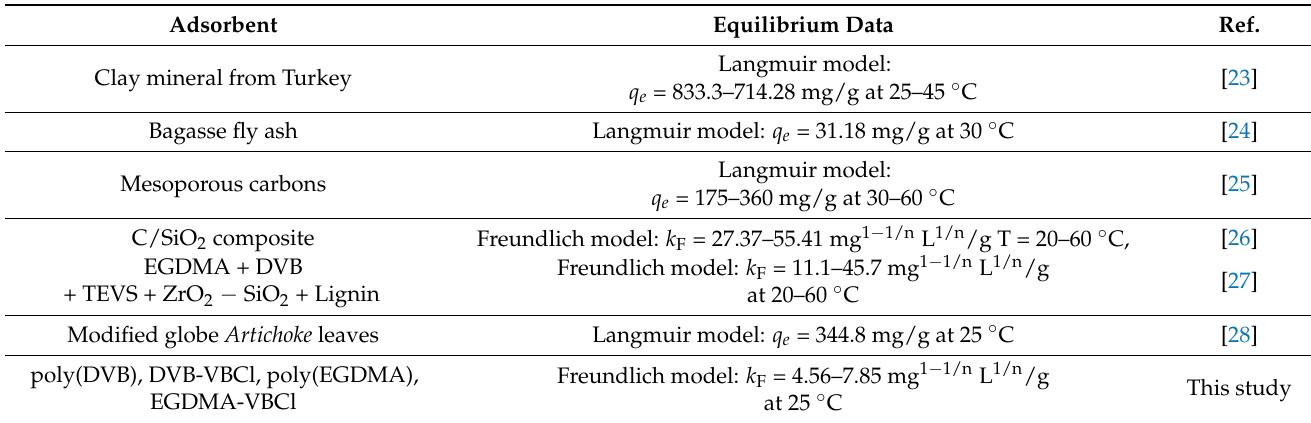
Table 3. Removal of auramine O by different adsorbents based on the literature review.